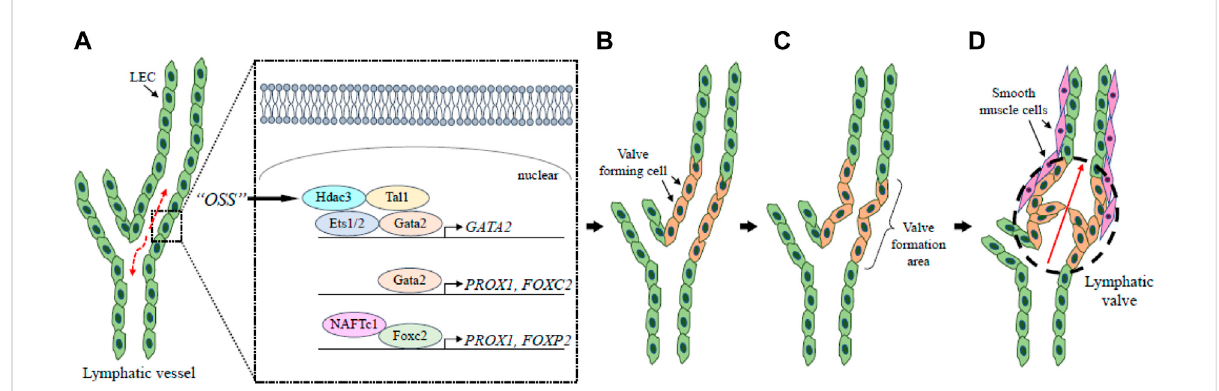
FIGURE 3 Lymphatic valve formation . The lymphatic valves are formed through lymph fl ow-dependent lymphatic vessel remodeling. At the bifurcation oflymphaticvessels,the fl owoflymphgeneratesOSS(brokenarrows)thatleadstotheupregulation of GATA2 inLECs via Hdac3 (A) .Gata2regulates PROX1 and FOXC2 expression to establish valve-forming cells (B) . Following these processes, the valve formation area is determined (C) , and the lymphatic valve (broken circle) has a role in keeping the lymph fl ow unidirectional (D) . Red arrow shows the direction of lymph fl ow. LEC, lymphatic endothelial cell; OSS, oscillatory share